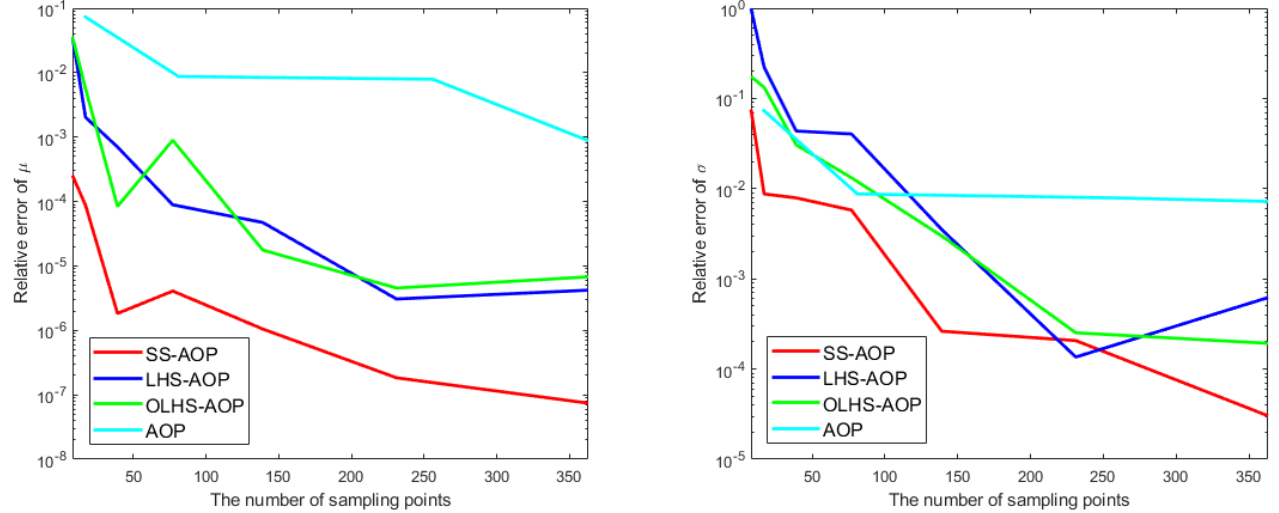
Figure 3. The relative error of mean value and variance for Case 1.